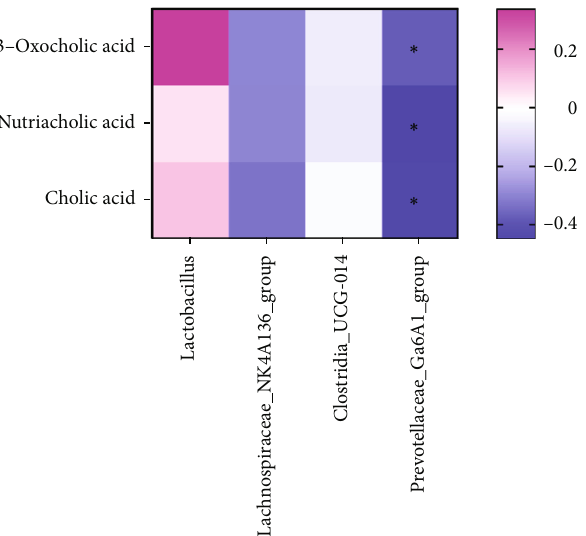
Figure 6: Correlation analysis of key gut microbiota and microbial metabolites. Pearson correlation coe ffi cient analyzed the correlation between gut microbiota and microbial metabolites. ∗ P < 0 : 05